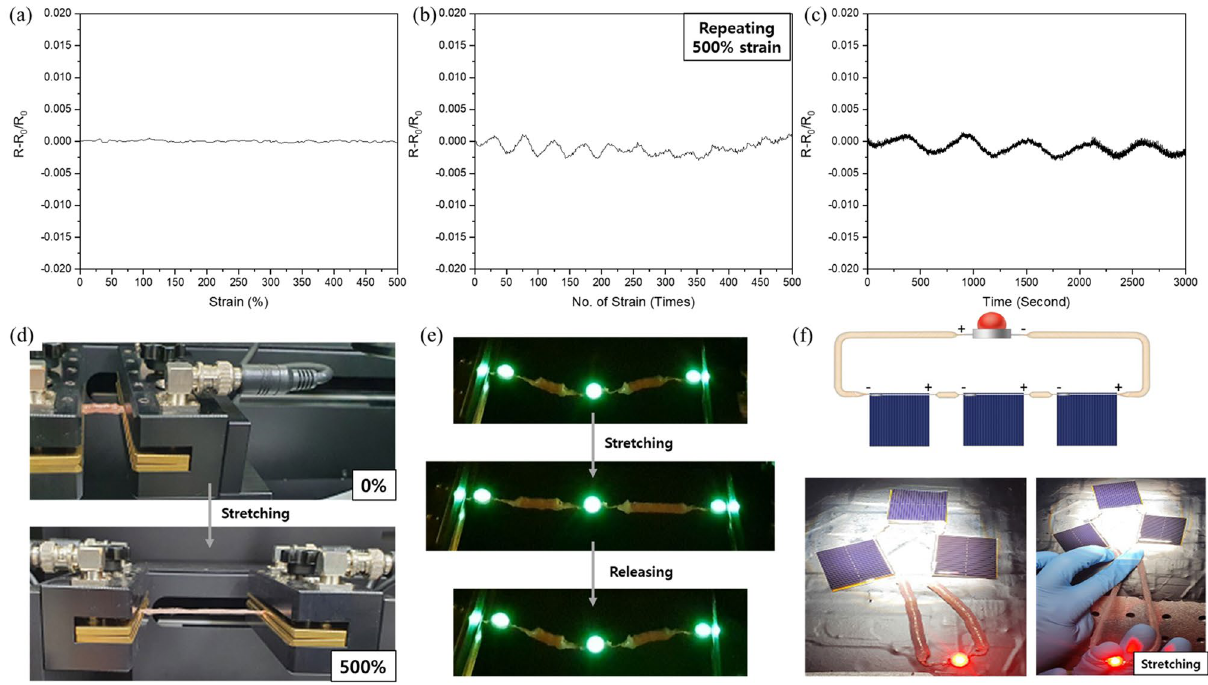
Figure 6. Measurement of the electrical resistance of the stretchable cylindrical textile interconnection during ( a ) strain to 500%, ( b ) 500 cycles of repetitive stretching to a strain of 500% and ( c ) repetitive stretching and recovery for 50 min. ( d ) Photographs of stretchable cylindrical textile interconnection before stretching and at 500% stretched state. LED lamps ( e ) integrated using the stretchable cylindrical textile interconnection during stretching deformation and ( f ) connected to a solar